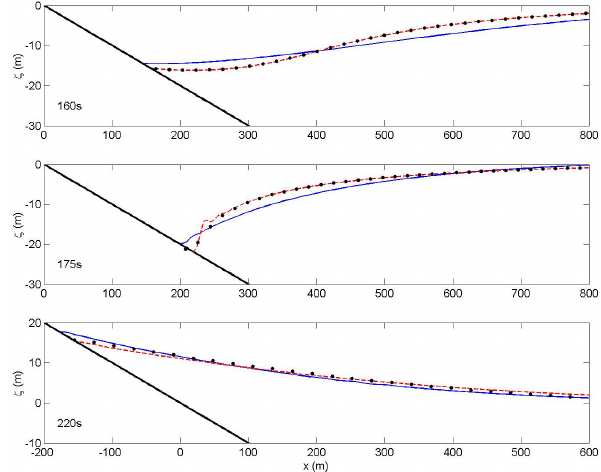
Fig. 2. Water surface profiles given by the analytical solution ( (cid:5) ), simulated with the FB model (—) and non-dispersive model (- -).